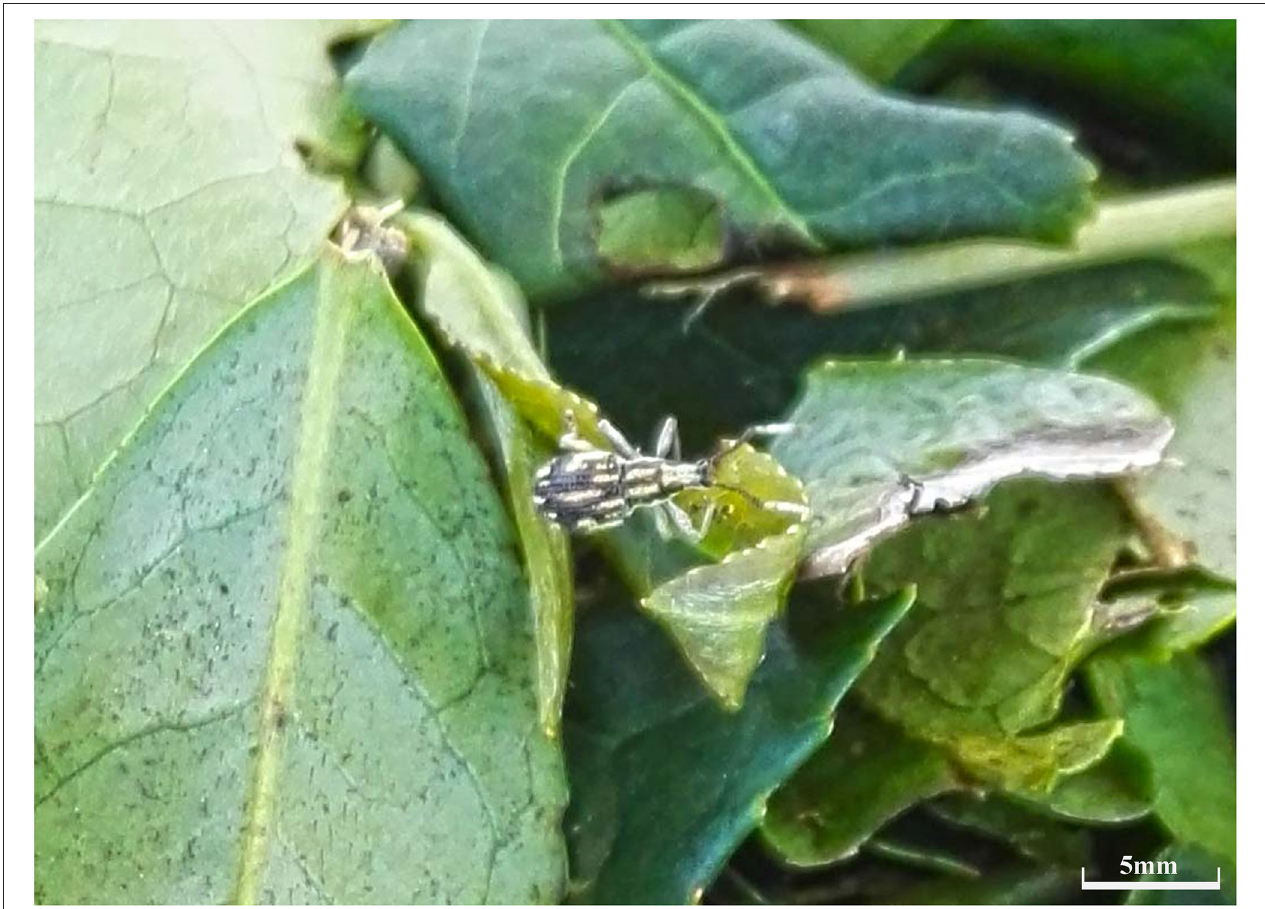
FIGURE 1 | The morphological characteristics of the adult M. aurolineatus on tea